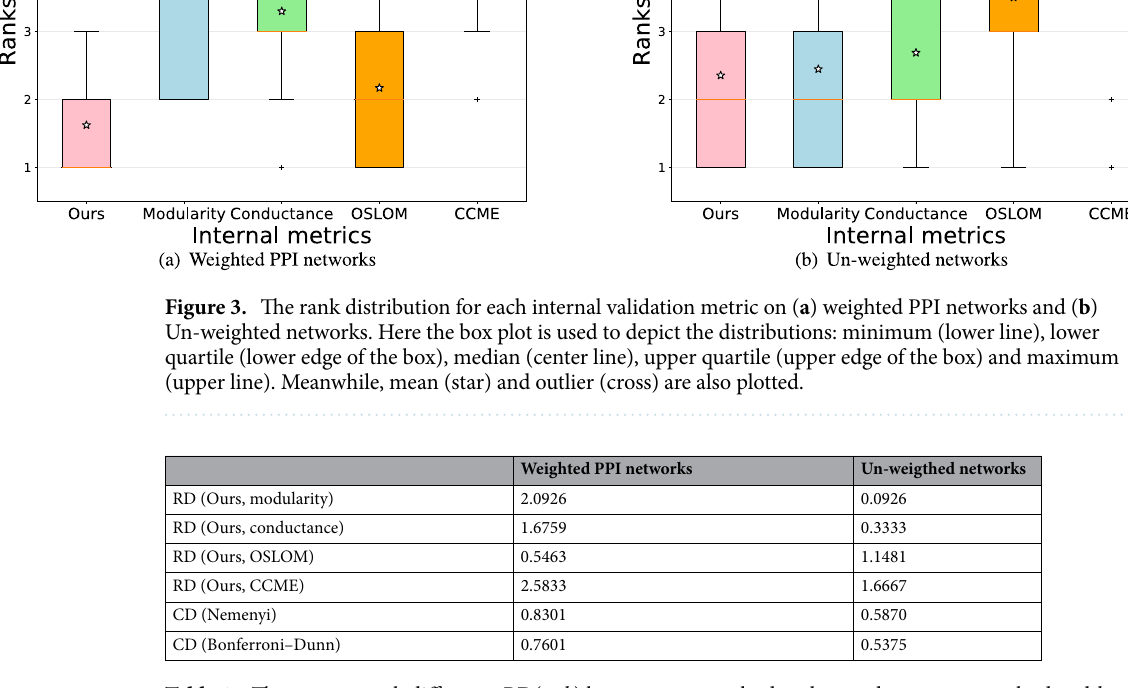
Table 1. The average rank difference RD( a , b ) between two methods, where a denotes our method and b represents a competing internal validation metric. In last two rows, the critical difference (CD) thresholds at the significance level α = 0.05 for the Nemenyi test and the Bonferroni–Dunn test are listed, respectively.